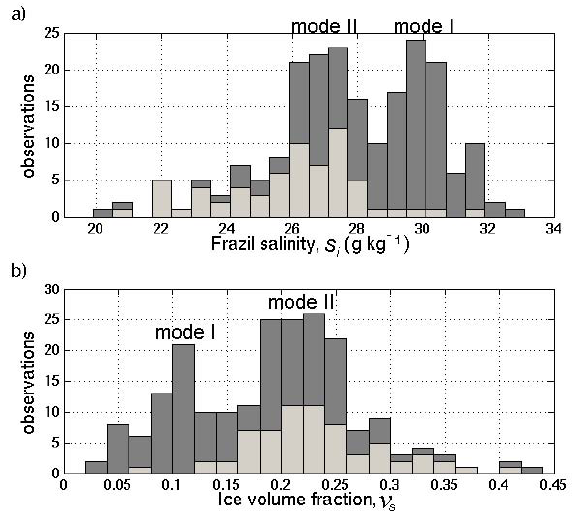
Fig. 6. Histograms for all experiment observations of (a) ice salinity centred in 0.6gkg − 1 bins and (b) frazil ice solid fraction, centred in 0.02 bins. Light gray distributions show data from E2 and E4